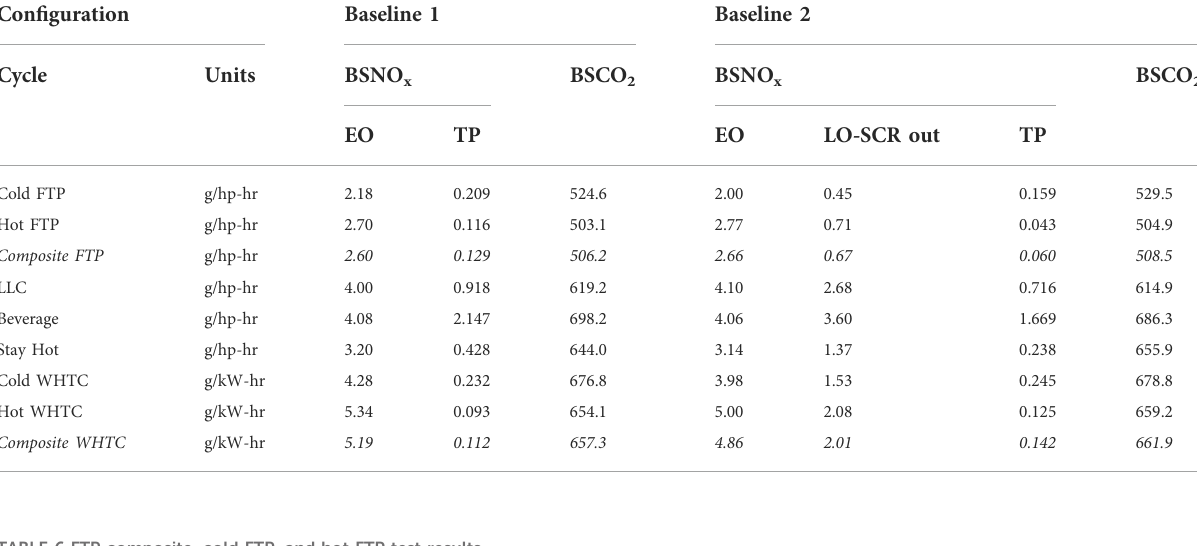
TABLE 6 FTP composite, cold FTP, and hot FTP test results